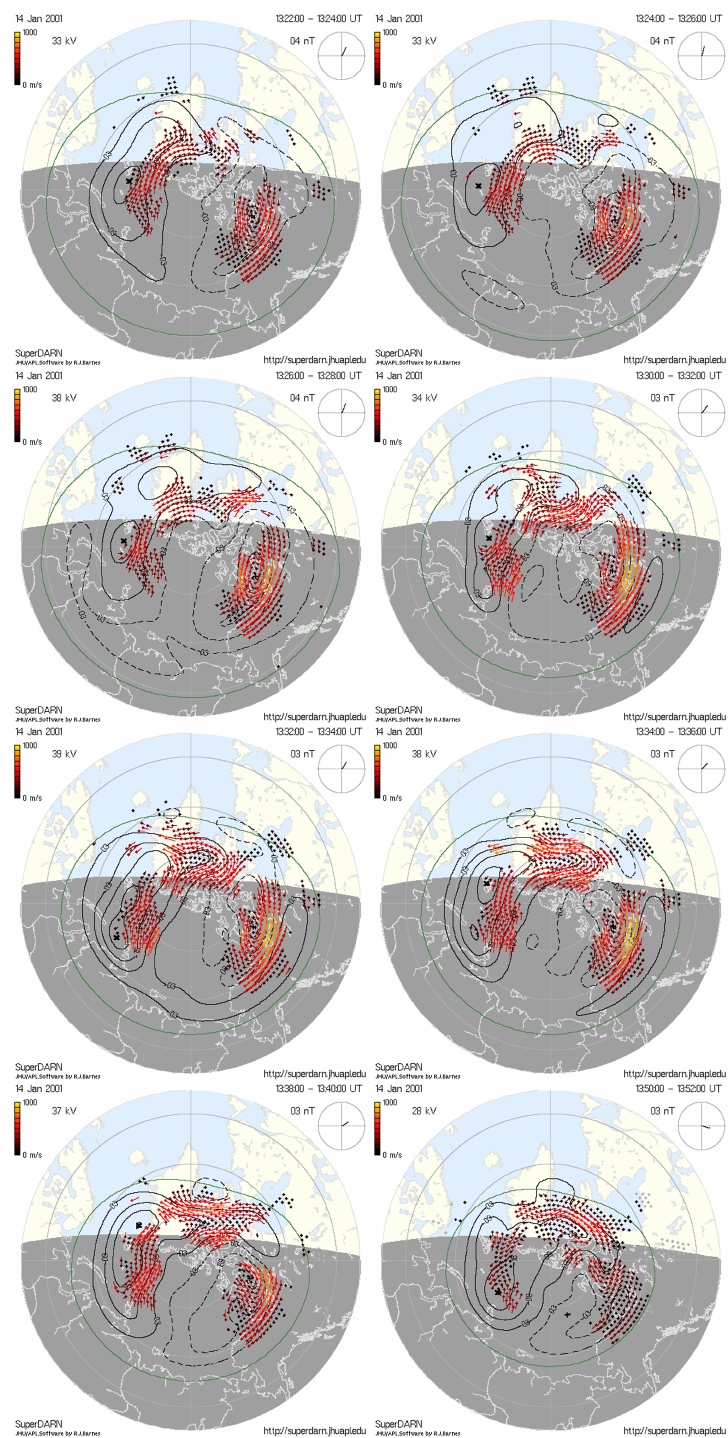
Fig. 6. Panel plot of 8 instances of global ionospheric convection as seen by the SuperDARN network between 13:22 and 13:52 UT on 14 January 2001. The flow vectors represents the fits of the actual line-of-sight velocity observations to a model convection pattern (black full and broken lines represents the electric potential contours), which in turn is constrained by the actual measurements and the solar wind influence on a convection model. The flow velocity is indicated by a colour scale and the derived cross-polar cup potential is given in the top left corner. The IMF data used is time-shifted ACE data (see dial in the top right corner of the